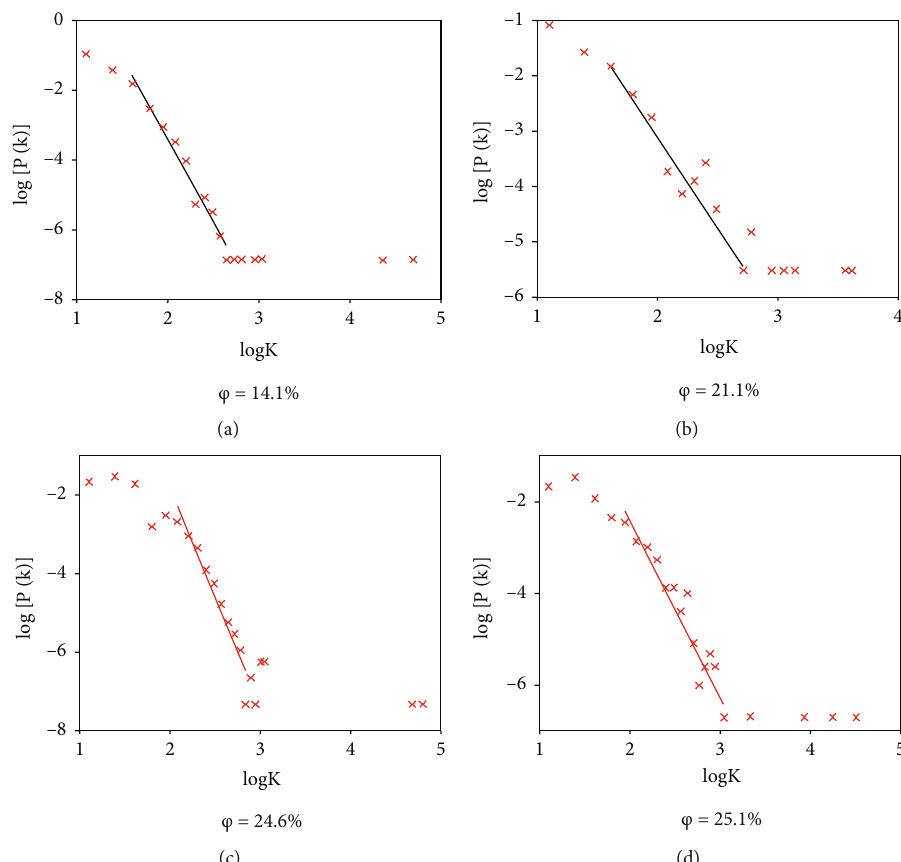
Figure 3: Double logarithm curve of degree distribution of di ff erent porosity sandstone seepage